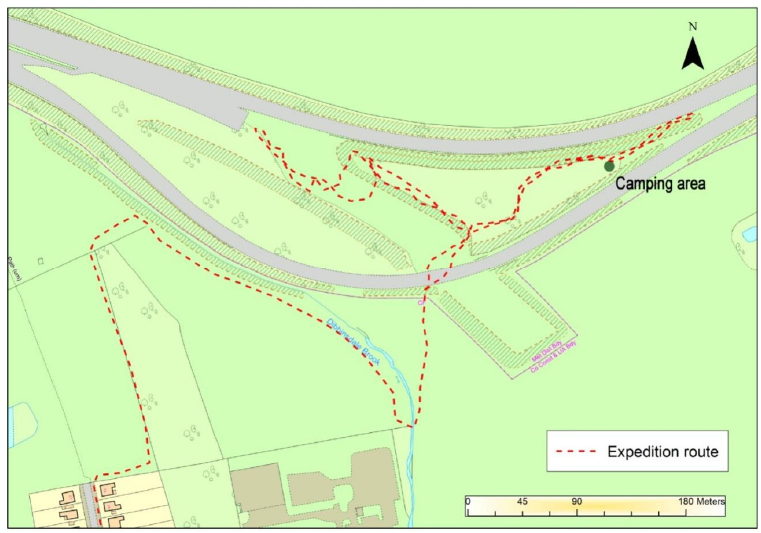
Figure 1. Ordnance Survey (OS) map of island showing expedition route, camping area and crossing points (1:2196). (Map data: © Crown Copyright and Database Right [2013]. Ordnance Survey (Digimap Licence)).